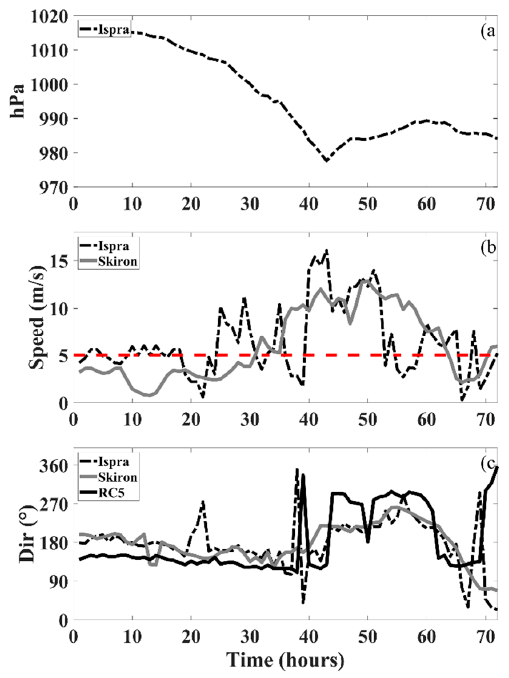
pressure (hPA), ( b ) wind speed (m/s) and ( c ) wind direction (°).